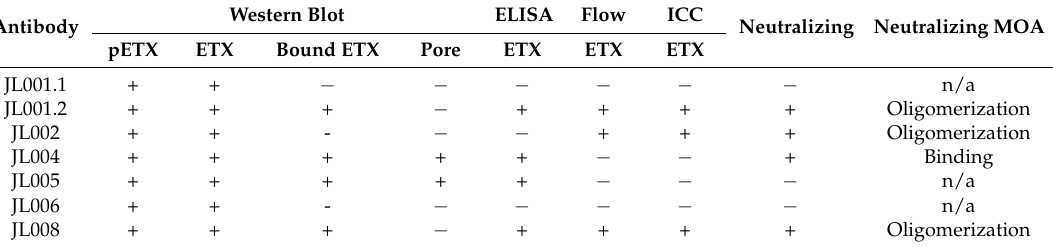
Table 1. Summary of antibody function in different